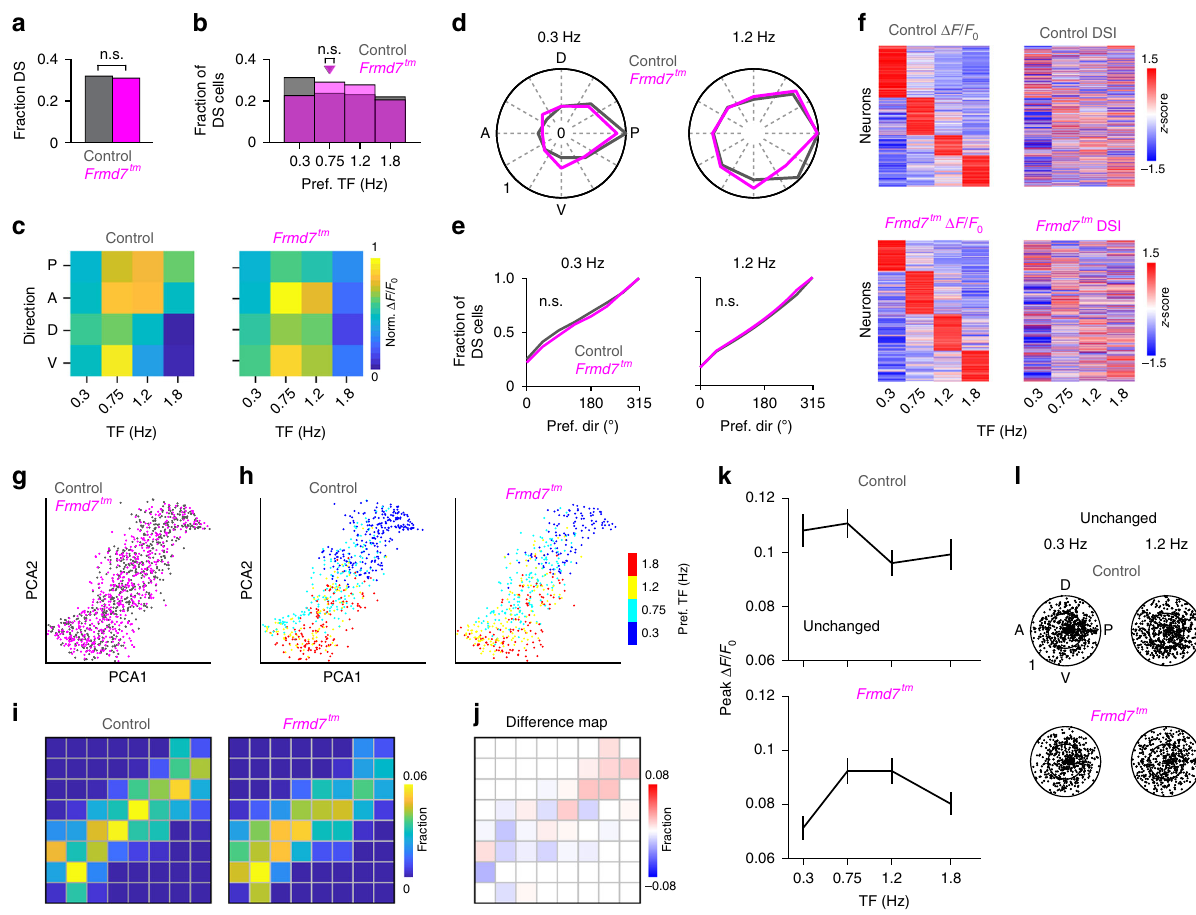
Fig. 5 Direction selectivity in V1 L4 is insensitive to disruption of retinal horizontal direction selectivity. a Fraction of DS cells in V1 L4 (678 and 536 DS cells in control and Frmd7 tm mice, respectively; four mice per group; two-sided χ 2 test with Yates correction). b Preferred TF for DS cells in V1 L4 (two- sided Mann – Whitney U -test). Triangles: Medians. c Response amplitude as function of motion direction and TF for V1 L4 DS cells. d Fractional distributions of preferred motion directions for V1 L4 DS cells at 0.3 and 1.2 Hz, normalized to the largest fraction across genetic groups. e Distributions of preferred motion directions at 0.3 and 1.2 Hz for V1 L4 DS cells (two-sided Kolmogorov – Smirnov test). f Response matrix composed of TF-dependent response amplitudes and DSI for V1 L4 DS cells sorted by TF preference. g Two-dimensional (2D) visualization of the 1st and 2nd principal components for the response matrix shown in f . Each point represents one neuron. h TF preference of individual V1 L4 neurons. i Fraction of neurons in 8 × 8 grids (gray lines) calculated from the PCA plot shown in g for control and Frmd7 tm mice. j Fraction difference map between control and Frmd7 tm mice. k Peak response amplitude as a function of TF for the unchanged group in control (678 DS cells) and Frmd7 tm mice (536 DS cells). Error bars are SEM. l TF-dependent tuning characteristics of individual V1 L4 neurons from the unchanged group in control and Frmd7 tm mice. Angular coordinate: preferred direction. Radial coordinate: DSI. Inner circle: DSI of 0.5. n.s., not signi fi cant. Source data are provided as a Source Data